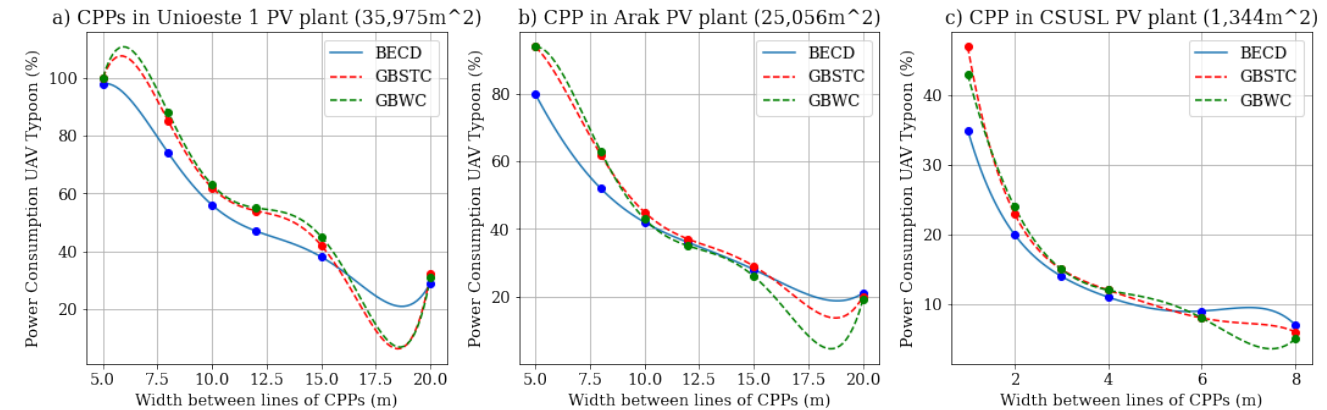
Figure 12. Performance test of Typhoon UAV varying the CPP